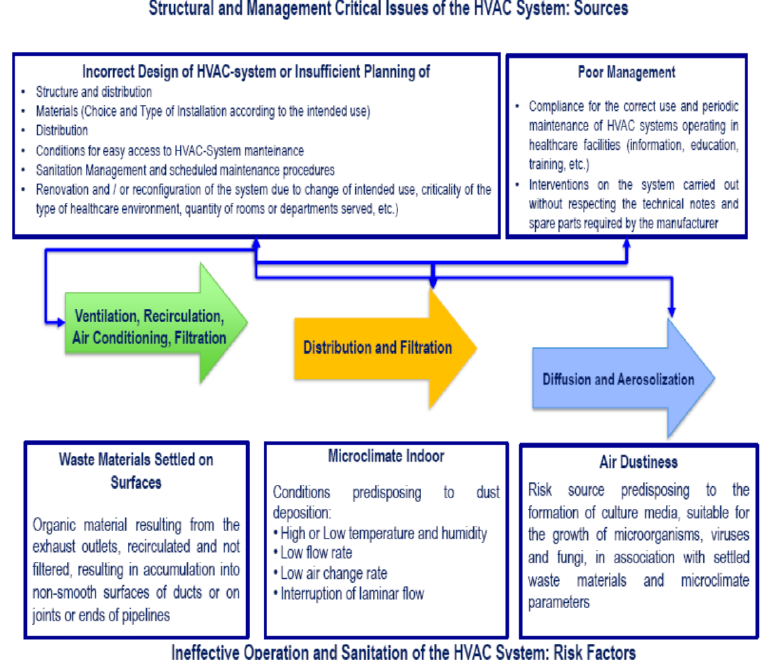
Figure 1. Sources, conditions and risk factors of contamination of the HVAC system: simplified scheme [47].